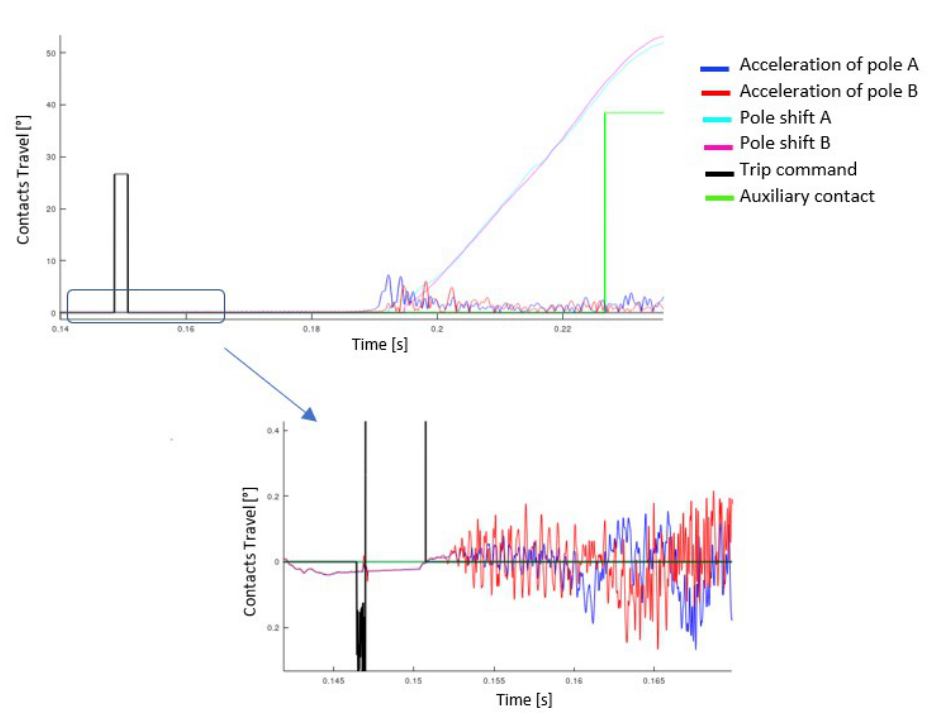
Figure 6. Instantaneous closing command (part 1).